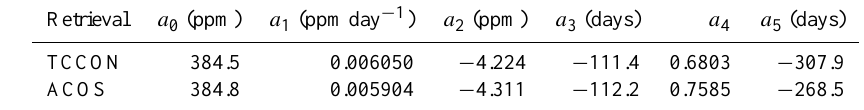
Table 2. Parameters defining the fitted seasonal cycle functions of co-located TCCON and ACOS soundings at Park Falls.